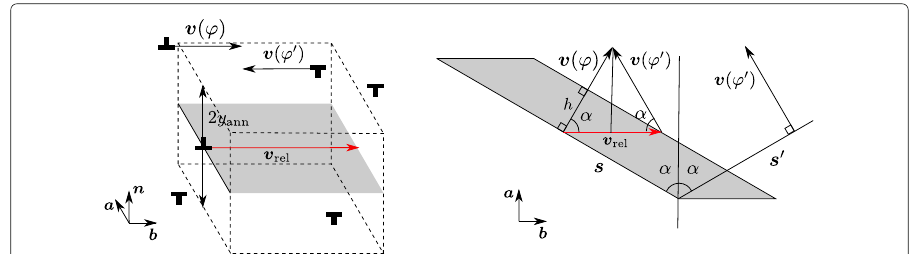
Fig. 1 Left: Differential annihilation volume of opposite edge dislocations is determined by multiplying their relative velocity v rel = 2 v w.r.t. each other with the line segment length w and the annihilation window 2 y cb and time step δ t : V a = 4 vy ann wdt . Right: Similarly, differential recombination volume of segments with orientation ϕ and ϕ (cid:10) = π + ϕ − 2 α ll (cid:10) is determined by multiplying their relative velocity v rel = 2 v cos w.r.t. the each other with the projected line segment w cos and the annihilation window 2 y cb and time step δ t : V a = 4 vy ann cos 2